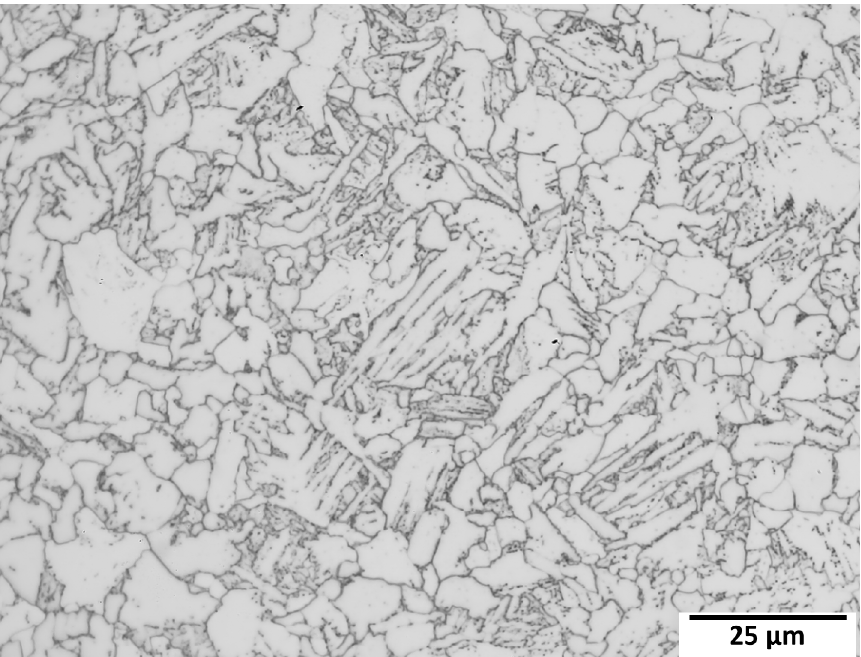
Figure 12. Micrograph of the cross section (longitudinal orientation; 1000 × ) of the 16-inch (41 cm) OD pipe; Q&T API-5L X42Q line pipe steel. For reference, the indenter diameter is 500 μ m, while the image shown is approximately 135 μ m wide.